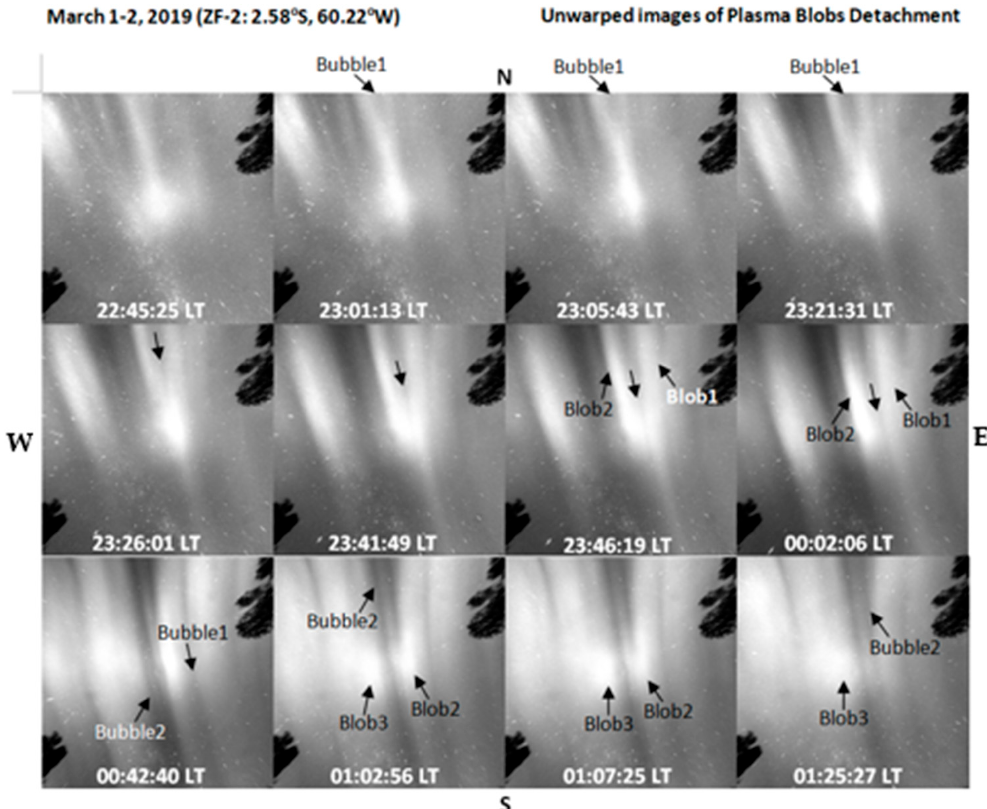
Figure 8. Unwarped sequential all-sky images of plasma blob bifurcation on the night of 1–2 March 2019, at ZF-2. The images show a dark structure (bubble) developing at the northern edge of the view, which splits the bright structure (blob).